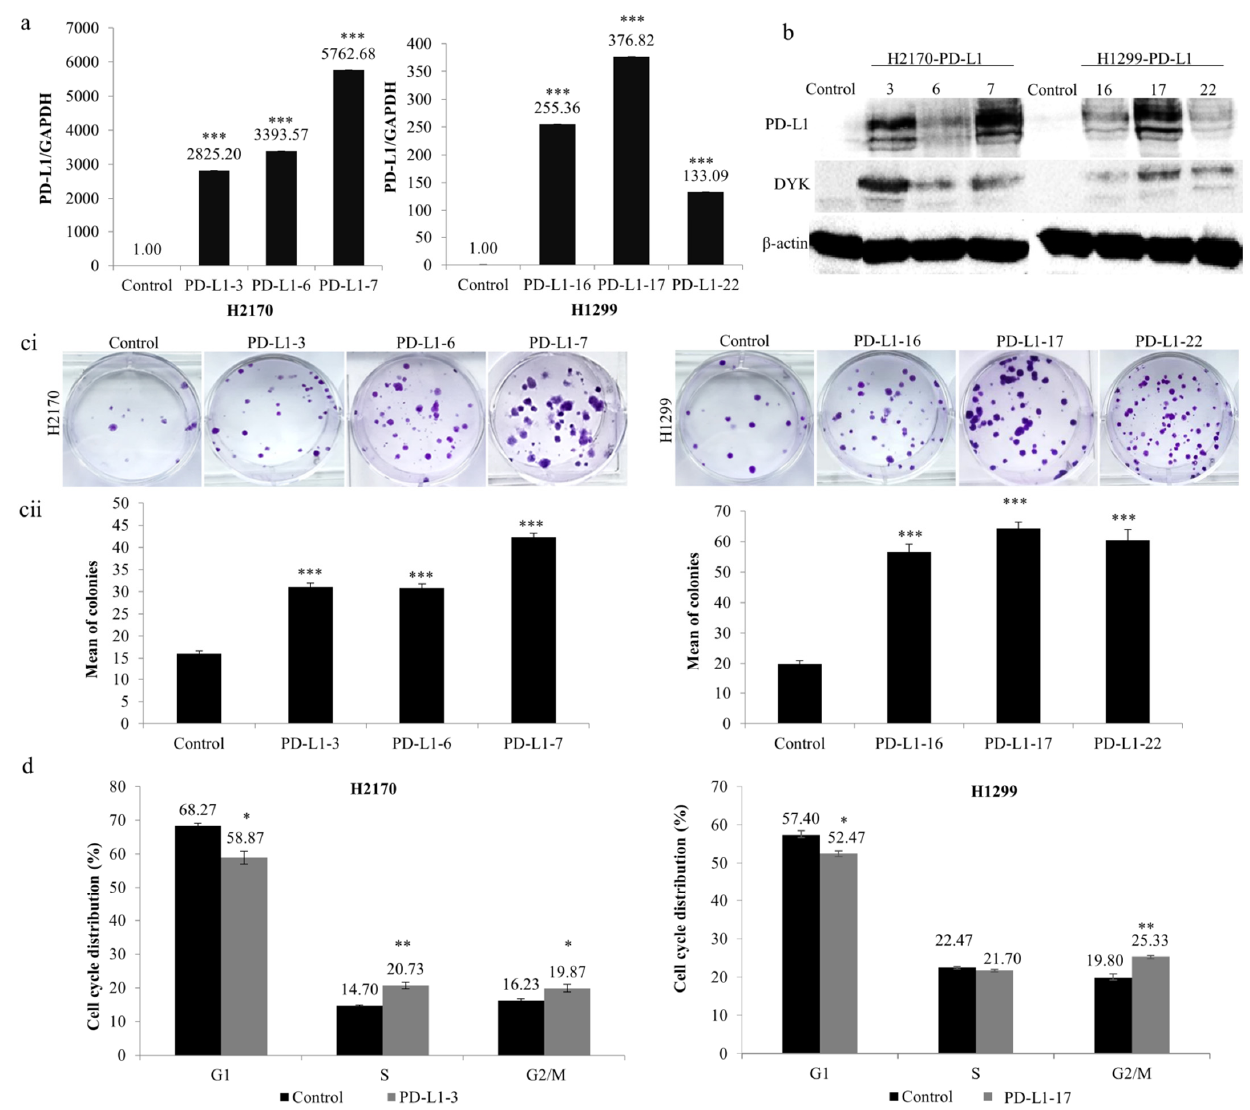
Figure 2. Influence of PD-L1 on colony formation and cell cycle progression in NSCLC cells. Overexpression of ( a ) PD-L1 mRNA and ( b ) PD-L1 protein in H2170 and H1299 cells after stable transfection, determined by real-time RT-PCR and Western blotting (WB), respectively. β -actin was used as a loading control for WB. PD-L1-3 (3), PD-L1-6 (6), and PD-L1-7 (7) are positive clones from H2170; PD-L1-16 (16), PD-L1-17 (17), and PD-L1-22 (22) are positive clones from H1299. Control cells were transfected with an empty vector. ( c ) PD-L1 overexpression increased H2170 and H1299 proliferation, as revealed by colony formation assay. Representative images of colony formation ( ci ; magnification 50 ×) and quantification of the number of colonies ( cii ). ( d ) Cell cycle analysis by flow cytometry showing that ectopic PD-L1 expression resulted in a significantly increased H2170 cell population in S and G2/M phases and increased H1299 cell numbers in the G2/M phase. * p < 0.05, ** p < 0.01, *** p < 0.001 when analyzed using Student’s t -test.